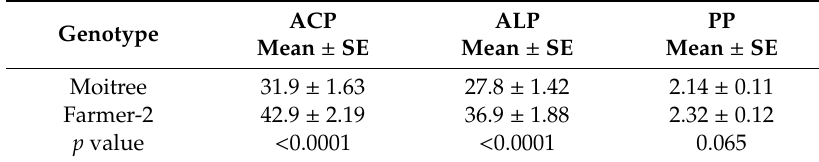
Table 2. Enzymatic activity of rhizospheric soil between two lentil cultivars under rice-fallow ecology.